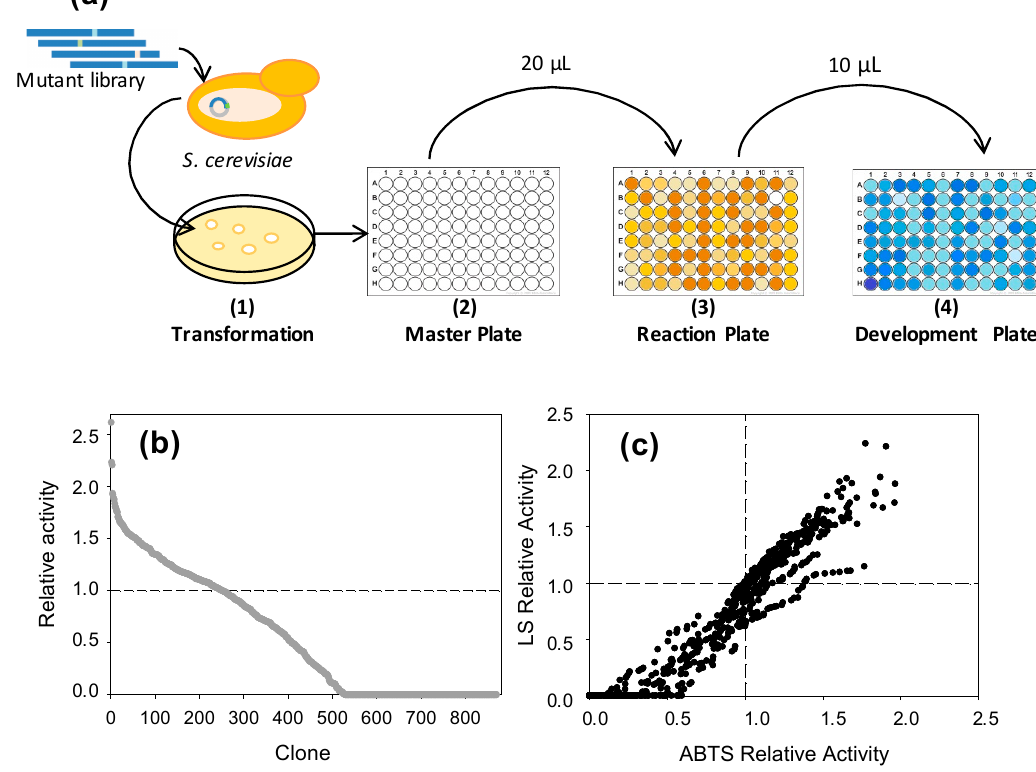
Figure 7. Scheme of the HTS protocol ( a ) including generation of the laccase mutant library and transformation in yeast (1), library expression in S. cerevisiae microcultures (2), transfer of supernatants to replica plates and reaction with LS (3), and color development by reaction of free phenolic groups with FCR (4). Landscapes for the activities of the clones of the mutant library screened with LS-FCR ( b ) or ABTS ( c ). Activity of parental LAC4 is depicted as dashed lines.